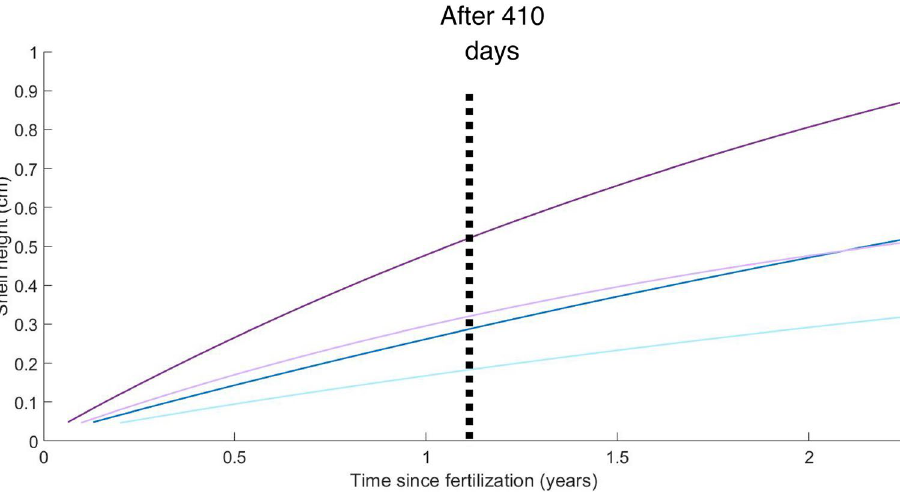
Figure 3. Prediction of the abj-DEB model of the evolution of the shell height of Xylonora atlantica under different environmental scenarios. At 2300 m in depth (T = 4 °C) with food level f = 0.5 (light blue) and f = 1 (dark blue); at 100 m in depth (T = 11 °C) with f = 0.5 (light purple) and f = 1 (dark purple) up to the lifespan at 4 °C (821 days).